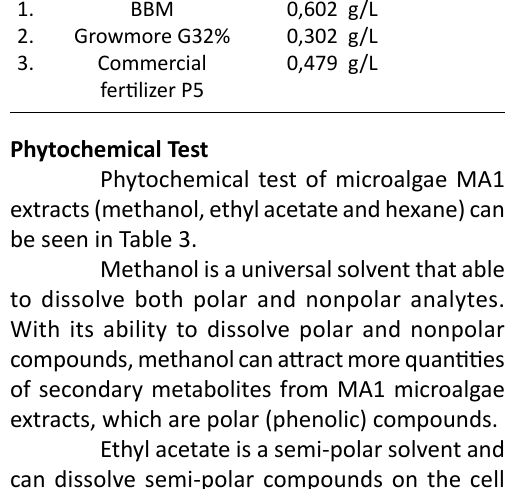
Table 2. Dry Biomass of MA1 Microalgae in 3 types of Medium